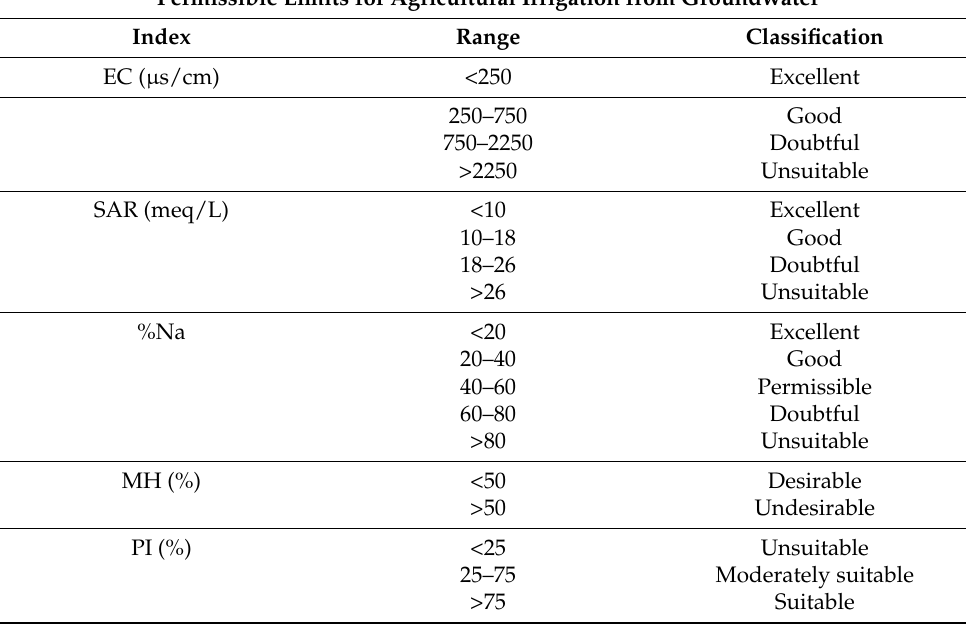
Table 3. Permissible limits for groundwater